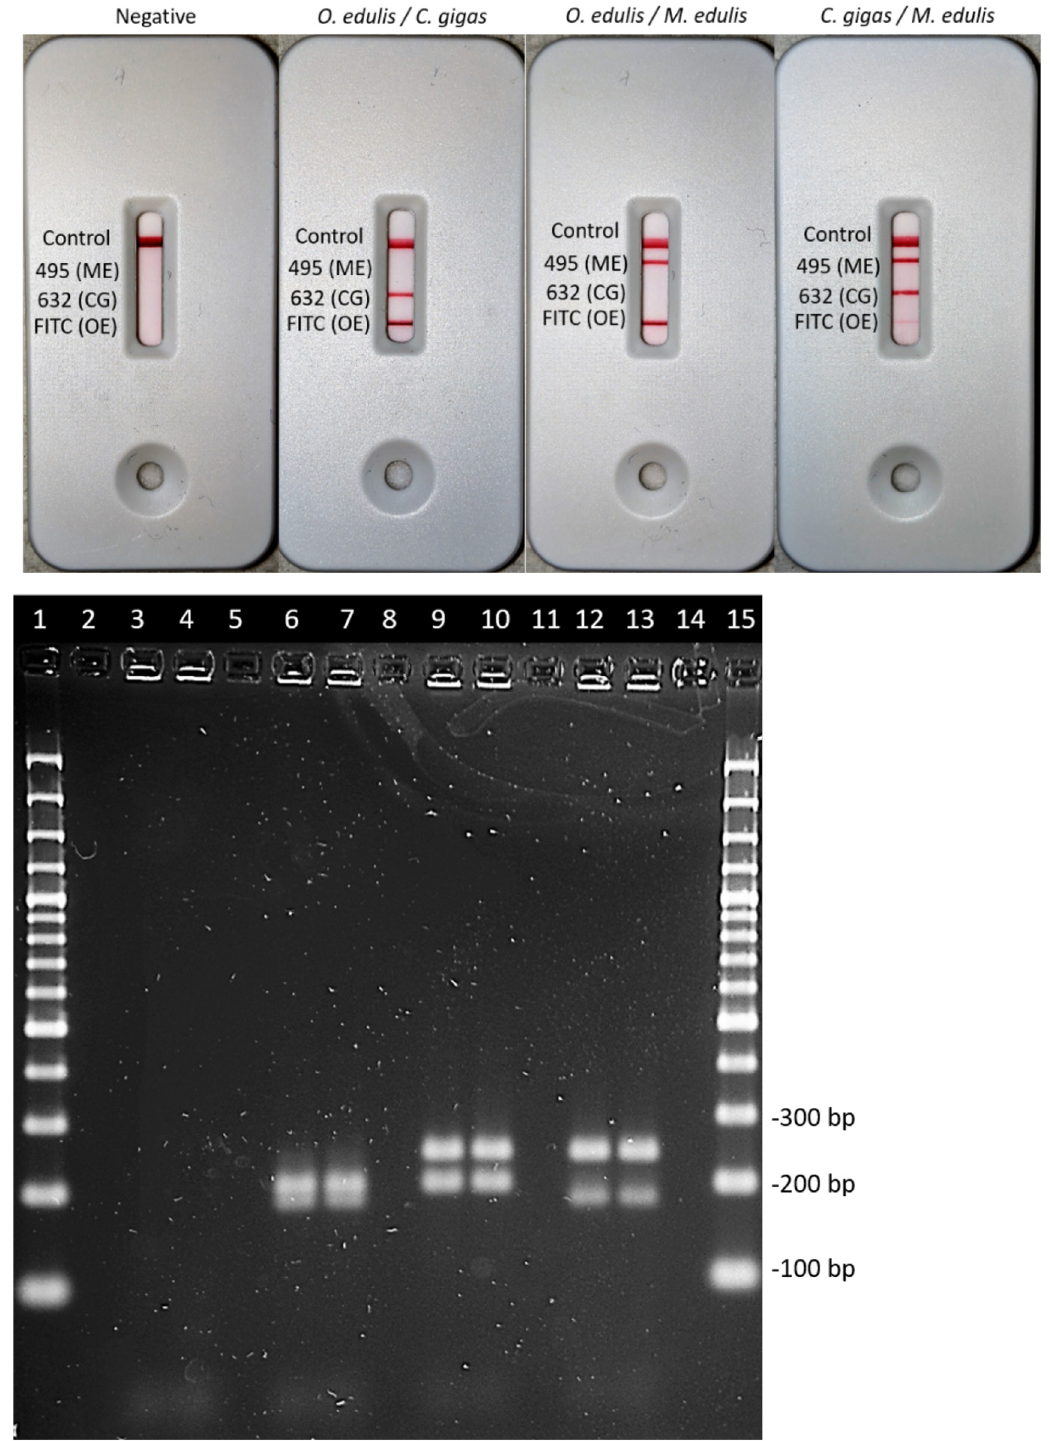
Fig. A2. Example of false-positive PCR-nucleic acid lateral fl ow immunoassay (NALFIA) with a combination of three primer pairs and two DNA templates in combinations of Ostrea edulis , Crassostrea gigas , and Mytilus edulis . The NALFIA for the negative control, O. edulis / C. gigas and O. edulis / M. edulis DNA templates, respectively, shows the expected results and are supported by the gel electrophoresis with the expected bands of the negative control on lane 3, lane 4, O. edulis / C. gigas DNA on lane 6, lane 7 and O. edulis / M. edulis DNA on lane 9, lane 10. Nevertheless, the NALFIA for C. gigas / M. edulis shows a false-positive result for O. edulis, but with no visible band for O. edulis on the gel electrophoresis expected at 191